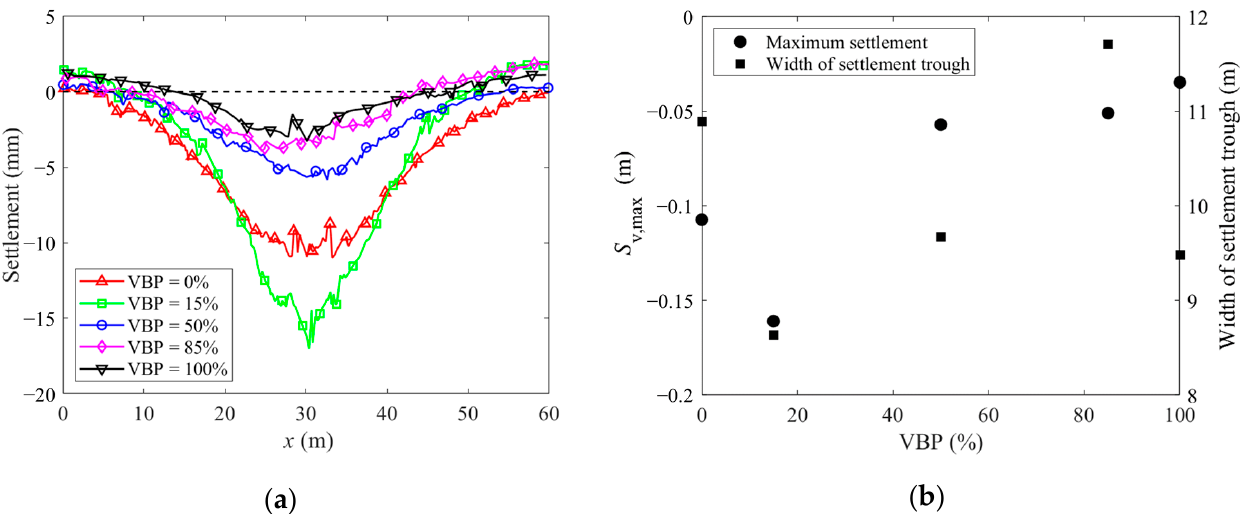
Figure 18. ( a ) The ground settlement curves with different VBPs. ( b ) The maximum settlement and width of the settlement trough as a function of VBP.